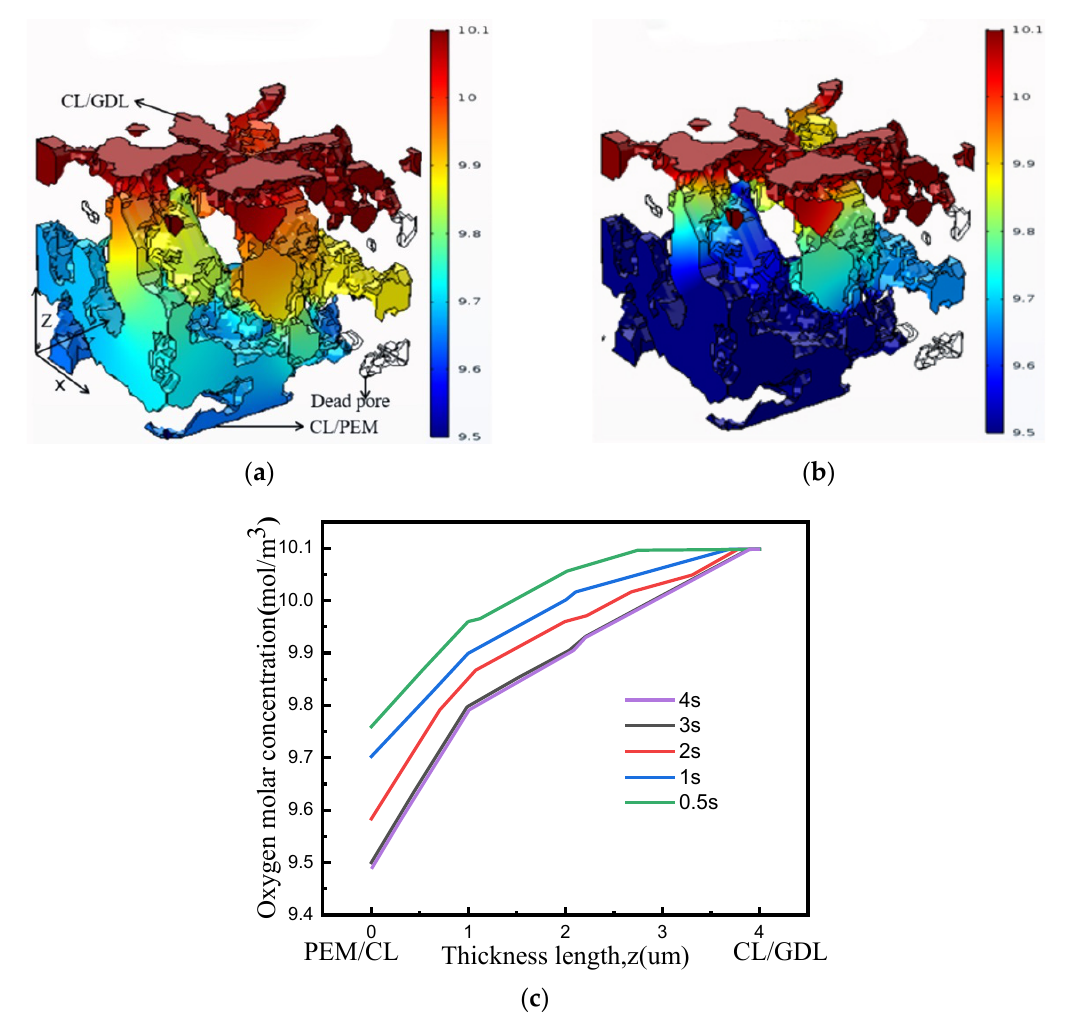
Figure 5. Distribution of oxygen molar concentration at different moments: ( a ) 1s, ( b ) 3s, and ( c ) oxygen molar concentration along the thickness of CL at different moments. ( c ) oxygen molar concentration along the thickness of CL at different